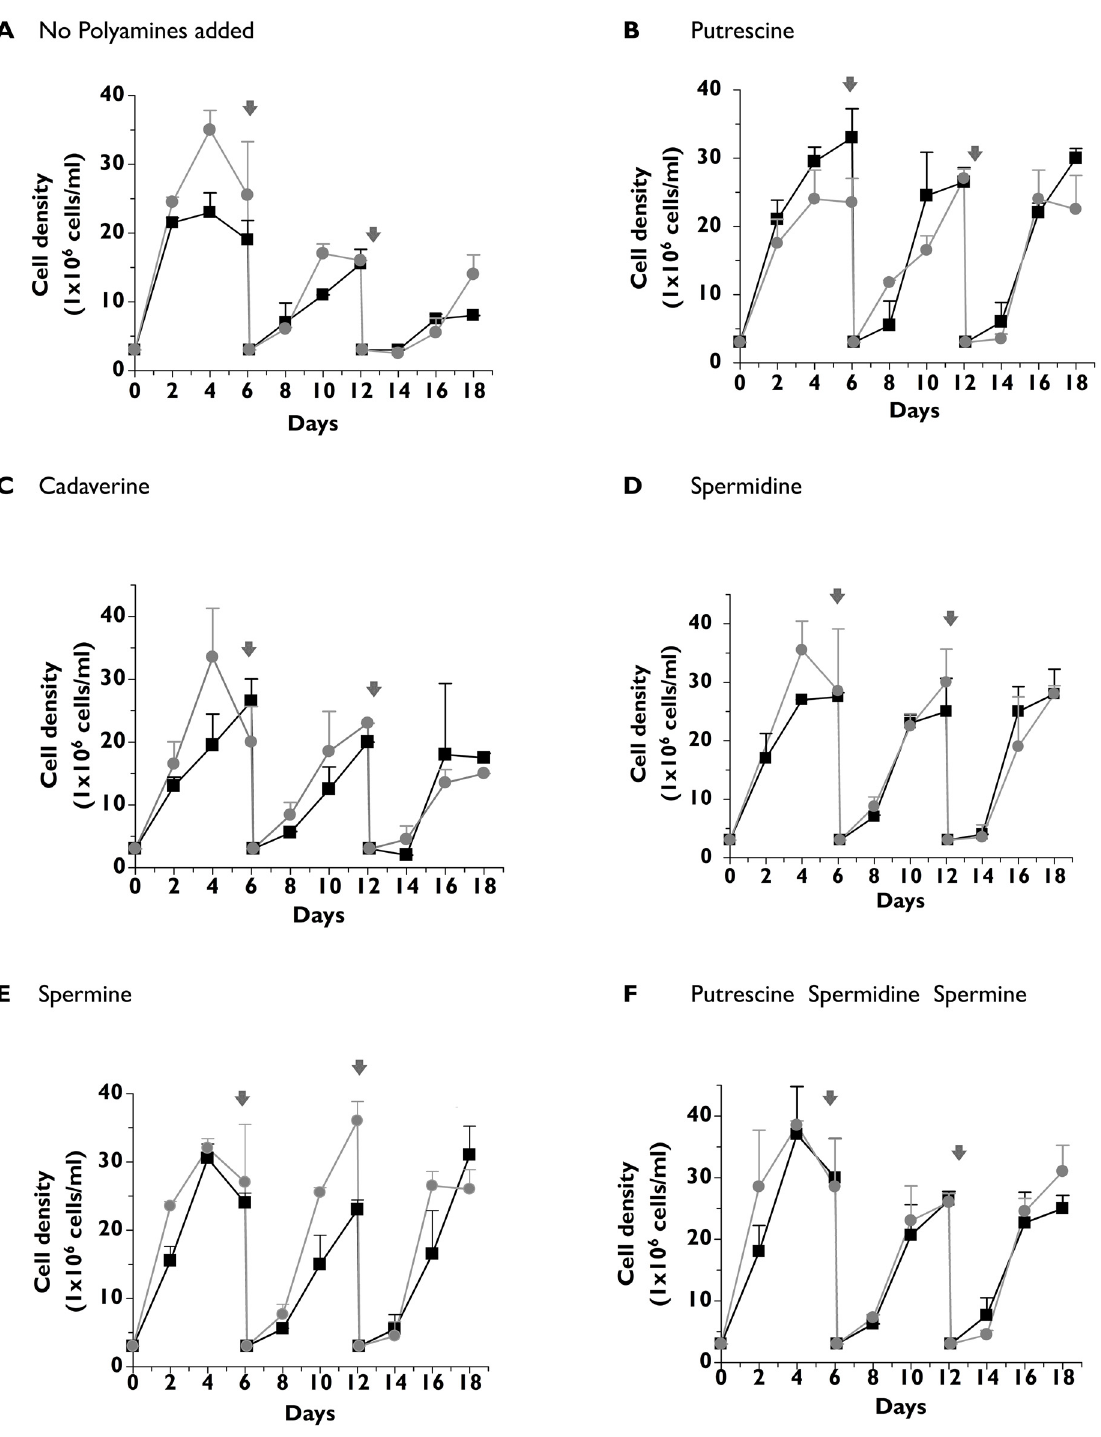
Fig 4. T . cruzi growth in the absence or presence of polyamines in the culture medium. The growth rates of wild type ( ● ) and Δ tcpot1 (grey dot) epimastigotes were determined over an 18 day time course in(A) the absence, or the presence of 200 μ M concentrations of either (B) putrescine, (C) cadaverine, (D) spermidine, (E) spermine, or (F) putrescine, spermidine and spermine in combination. Parasites were seeded at 3 X 10 6 cells ml -1 and cell densities assessed every 2 days. On days 6 and 12, cell cultures were diluted back to a density of 3 X 10 6 cells ml -1 . The dilutions are indicated in the panels by a gray